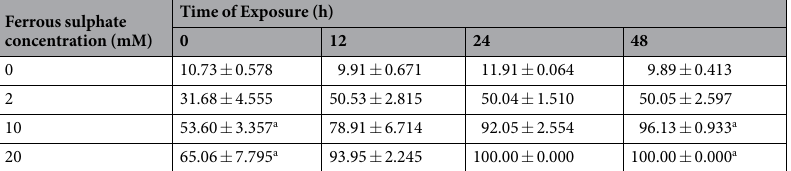
Table 1. Mortality (%) of ISE6 cells exposed to different concentrations of ferrous sulphate at different time points. Data are presented as mean ± S.D. The results for the normality and homogeneity are presented in Table S1. A one-way ANOVA with Bonferonni multiple comparison test was performed (Tables S2 and S3). Statistical significance was set as * P < 0.05. Columns with the same superscript are not significantly different at P < 0.05. The data presented are results of three separate experiments with two technical replicates for each